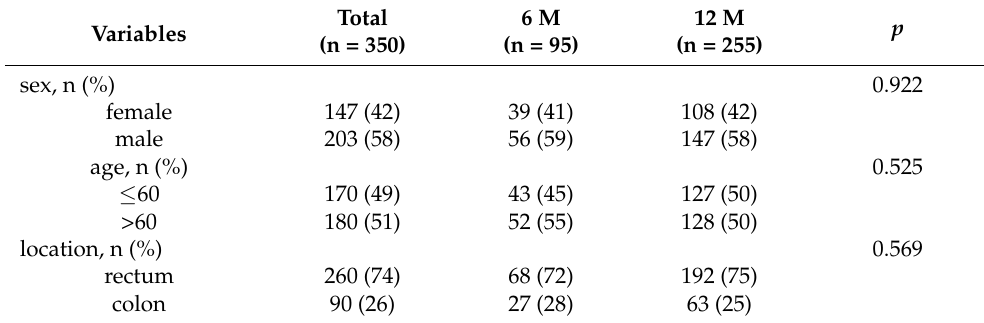
Table 1. Characteristics of study by duration of adjuvant